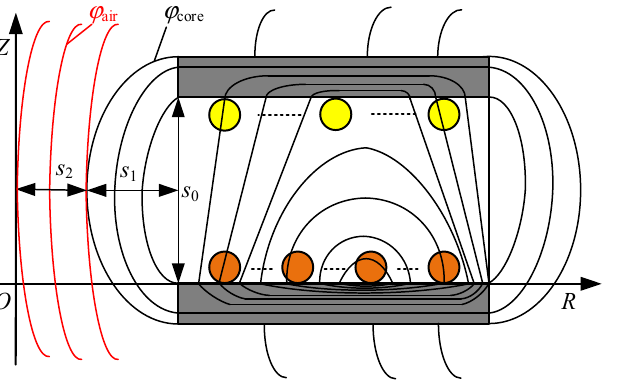
Figure 5. The schematic diagram of the magnetic field line distribution in the magnetic coupling system.